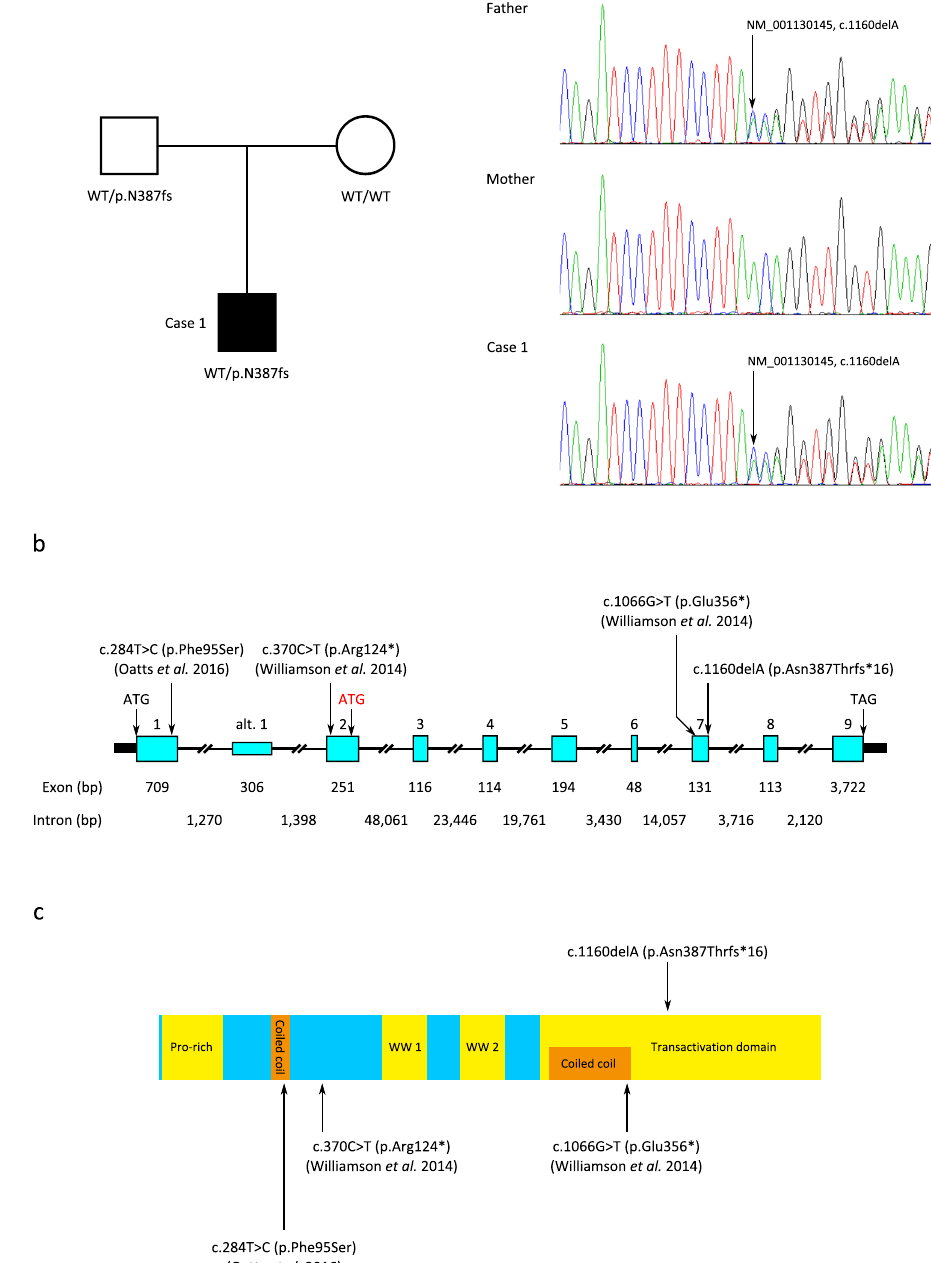
Figure 2. Identification of a novel YAP1 frameshift mutation in a patient with developmental eye disorders. ( a ) The mutation is heterozygous in the patient and inherited from his asymptomatic father. ( b ) Schematic of the genomic structure of YAP1 . Exons are indicated by boxes and are drawn to scale with the exception of the untranslated regions (shown as solid black boxes). Exon and intron sizes are shown beneath. Initiation and termination codons are indicated, with the alternate initiation codon of the NM_001195045.1 transcript indicated in red. The positions of the c.1160delA (p.Asn387Thrfs * 16) reported here and the co-segregating nonsense mutations identified by Williamson et al . 7 and the missense mutation identified by Oatts et al . 9 are indicated. Alt. 1 = alternative exon 1 (NM_001195045.1 transcript). ( c ) The p.Asn387Thrfs * 16 variant is located within the transactivation domain of YAP1 (NP_001123617). The locations of the co-segregating nonsense mutations identified by Williamson et al . 7 and the missense mutation identified by Oatts et al . 9 are also